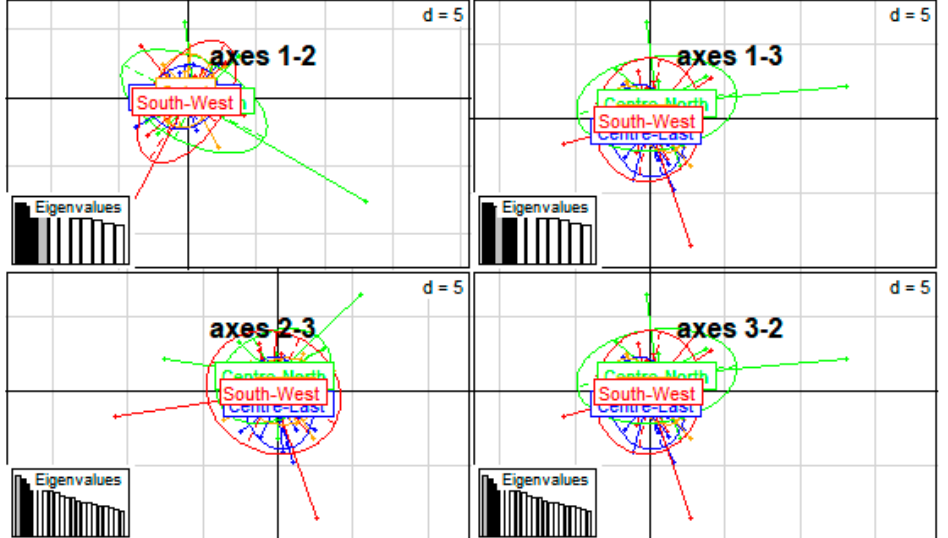
Figure 6. Graphical representation of the discriminant principal component analysis (DAPC) using four local chicken ecotypes from the Centre-East (ecotype Konde), Centre-North, Sahel and South- West regions of Burkina Faso for spatial distribution.